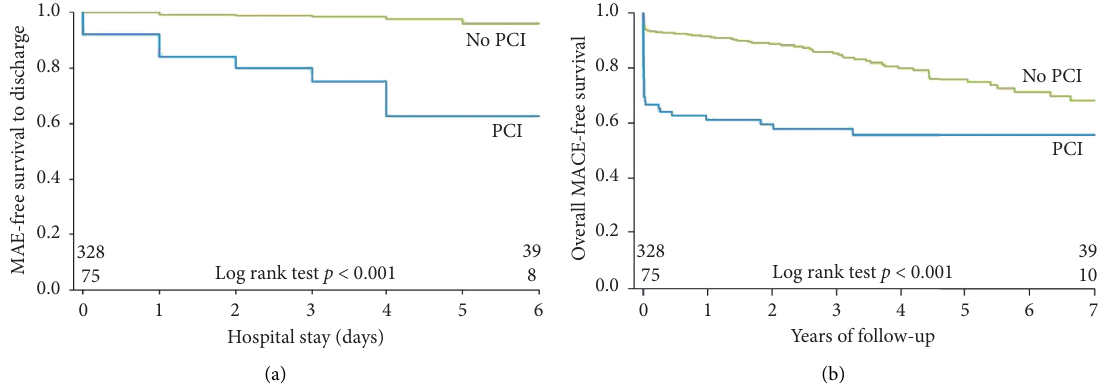
Figure 4: Kaplan–Meier event-free survival curves for PCI versus non-PCI group: (a) in-hospital major adverse events and (b) overall major adverse cardiovascular